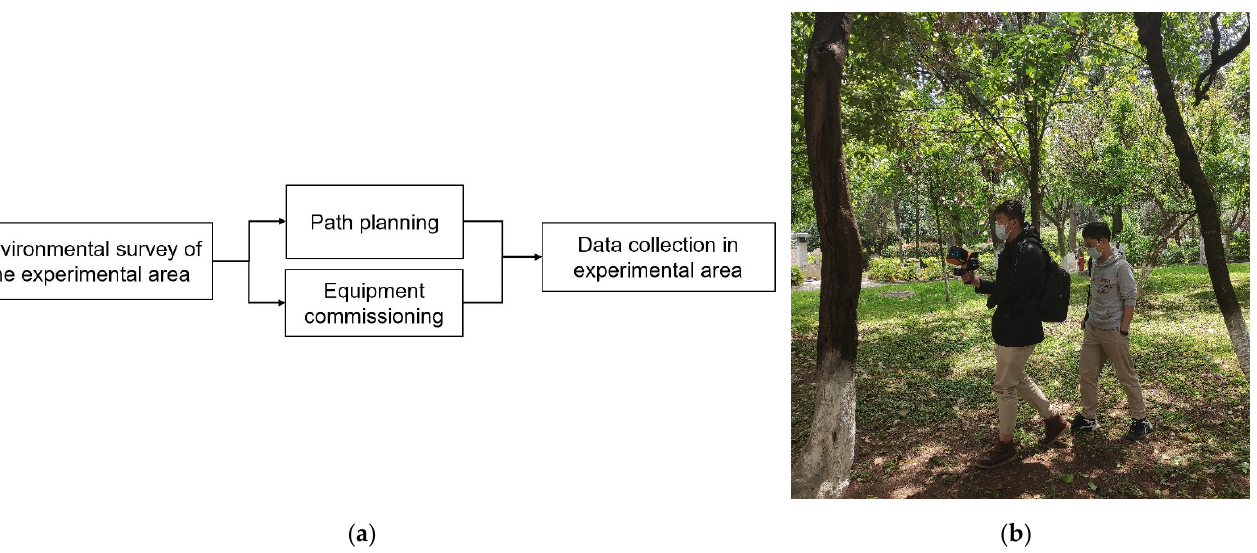
Figure 5. Data acquisition flow chart. (( a ) shows the flow chart of data acquisition; ( b ) shows the data collection of the experimental area).